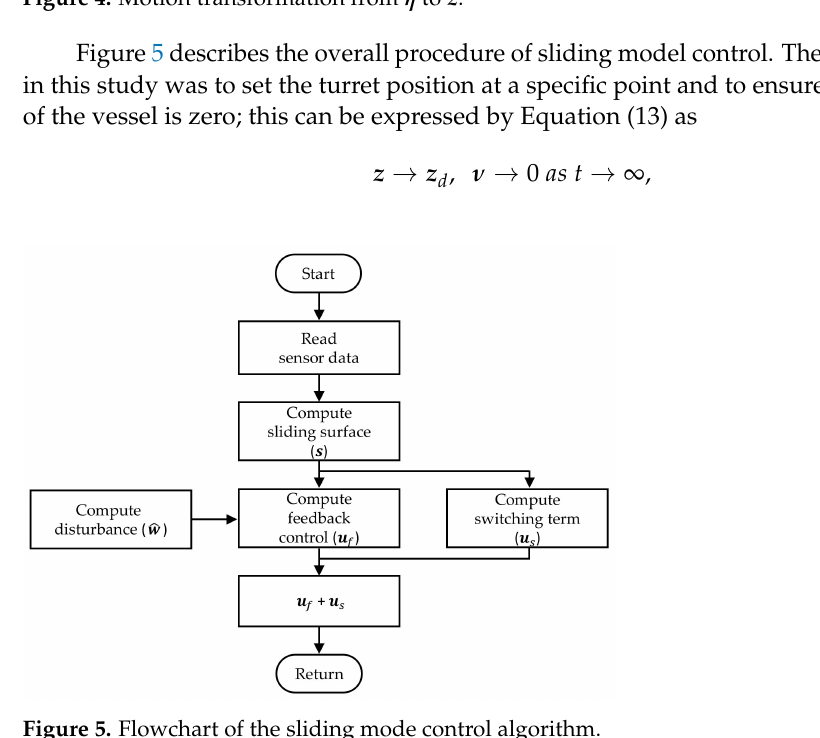
Figure 4. Motion transformation from η to z .